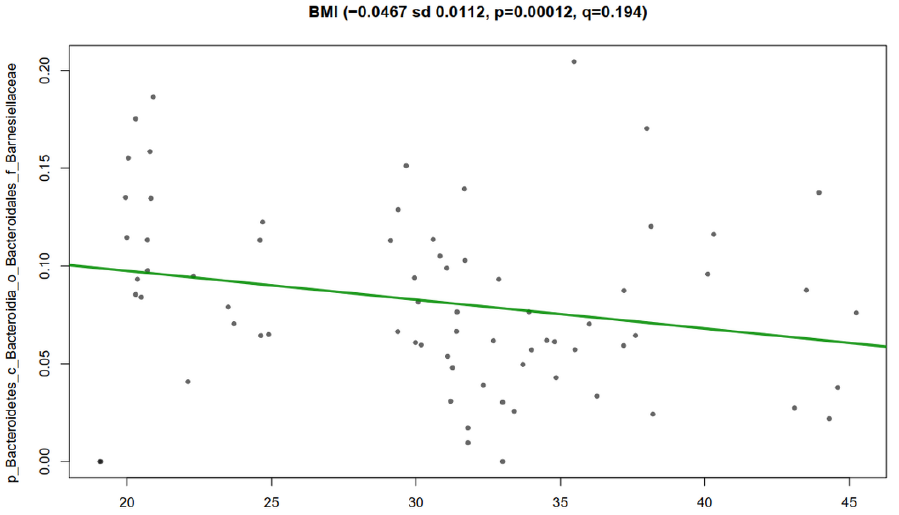
Figure 5. Multivariate linear associations of clinical metadata and bacterial relative abundance in all participants. Scatter plot explains the significant association of Body Mass Index (BMI) with the family Barnesillaceae as described in Materials and Methods. y -axes show the relative abundance of the bacteria; x -axes show the BMI data. Numerical data on top of graphic are coefficient (negative coefficient shows negative association between BMI and Barnesillaceae ), sd—standard deviation; p -values, and FDR corrected q -values which are assigned by MaAsLin (v0.0.4). Obesity (BMI 29–45) and normal weight (BMI 19–24).